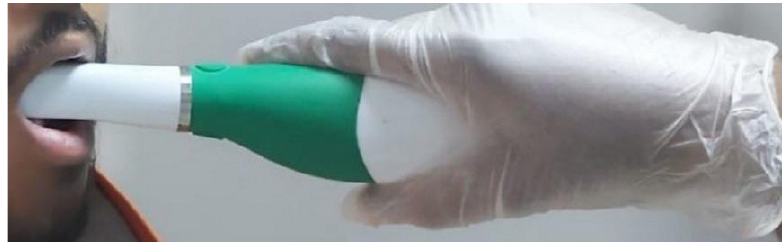
Figure 3. Intra-oral ultrasonography.